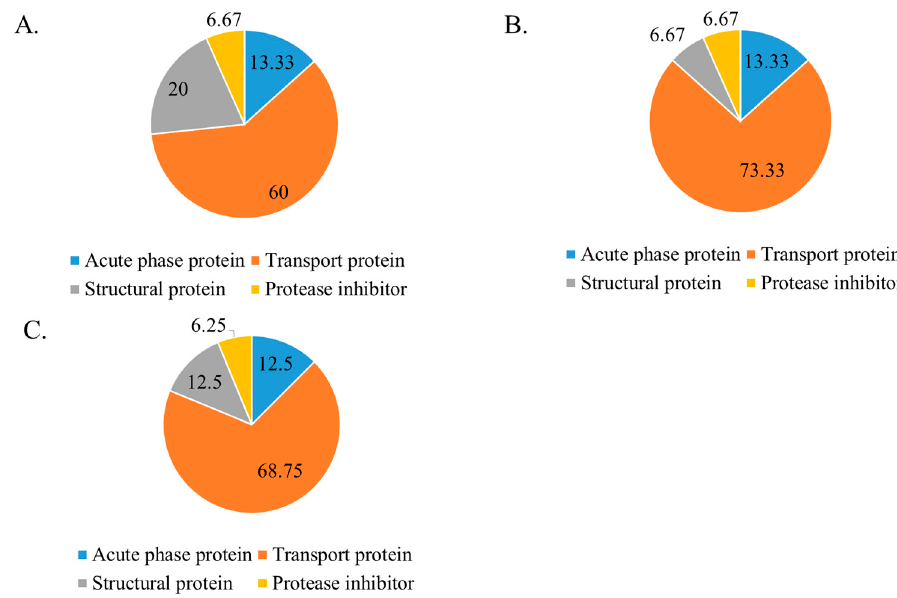
Figure 10. Protein distribution (%) around—( A ) CA NPs in 10% fetal bovine serum (FBS), ( B ) CMCA NPs in 10% FBS, and ( C ) α -KAMCA NPs in 10% FBS.